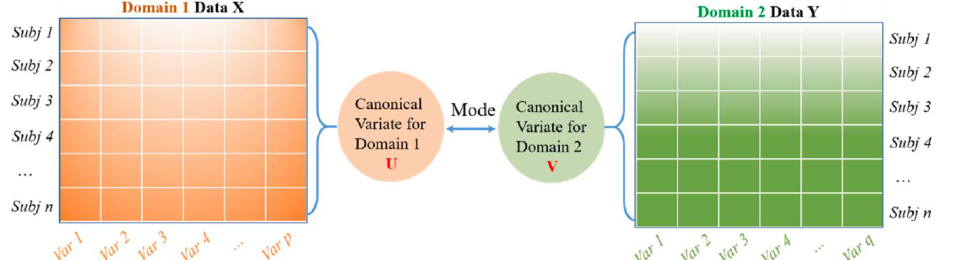
Figure 1. A general schematic for CCA to model the correlation between two feature datasets. Reprinted/adapted with permission frm Ref. [50].Copyright from Li. et. al., Mech. Syst. Signal Process; published by Elsevier Ltd., 2022.